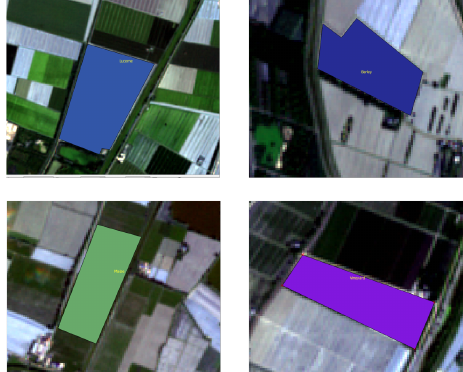
Figure 2. Several examples of zoomed in parts of crop classes considered as ground truth. Shape files are used to extract pixels for reference